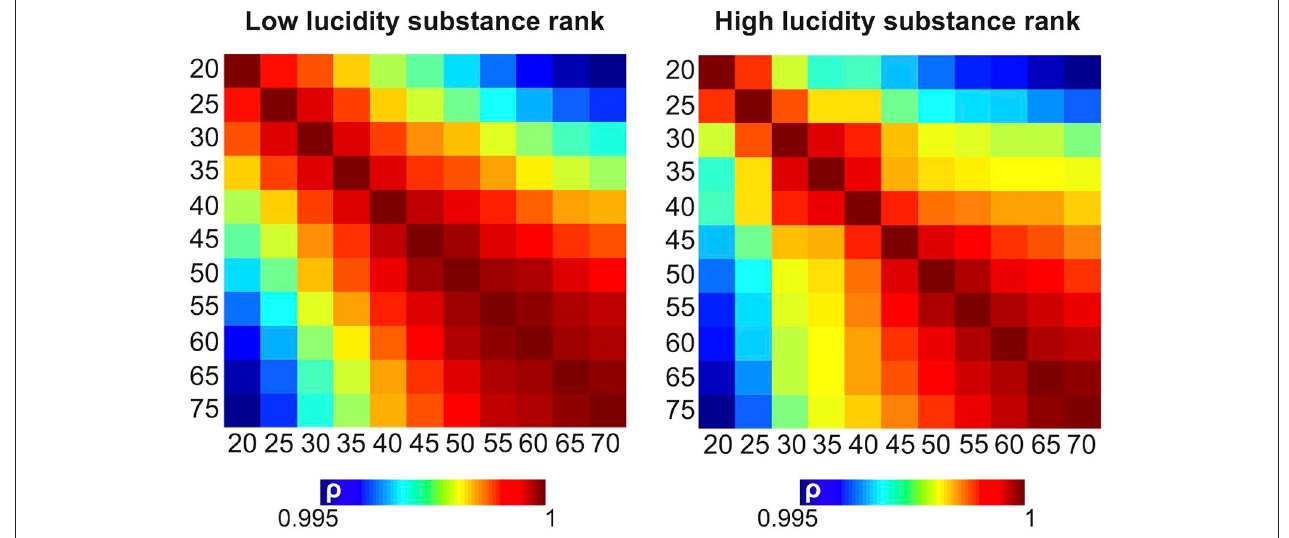
FIGURE 8 | Pairwise correlation matrices between the rank of the substances in terms of their similarity to dreams of low (left) and high (lucidity), computed after retaining different numbers of singular